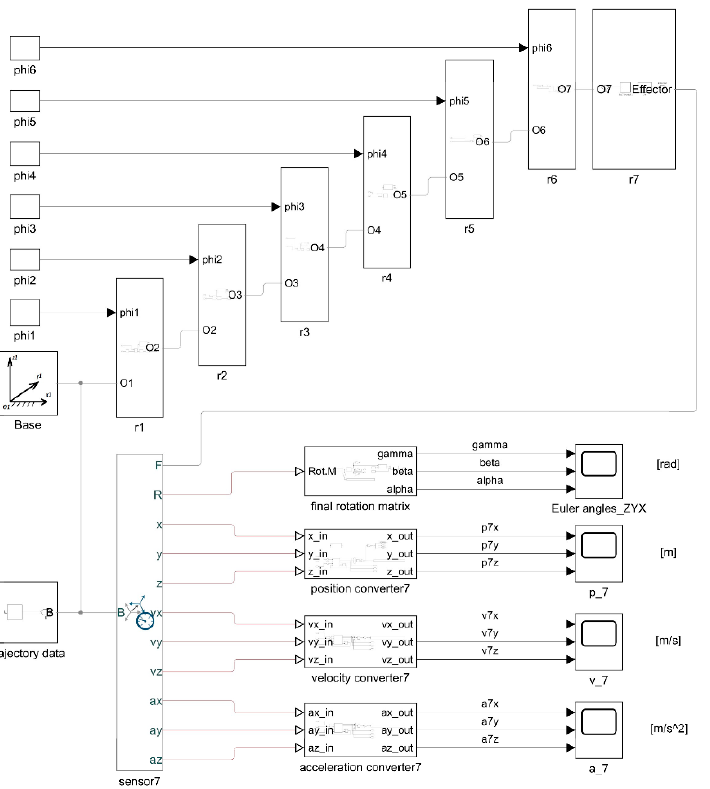
Figure 3. Model created in Matlab-Simulink using the Simscape/Multibody toolbox.